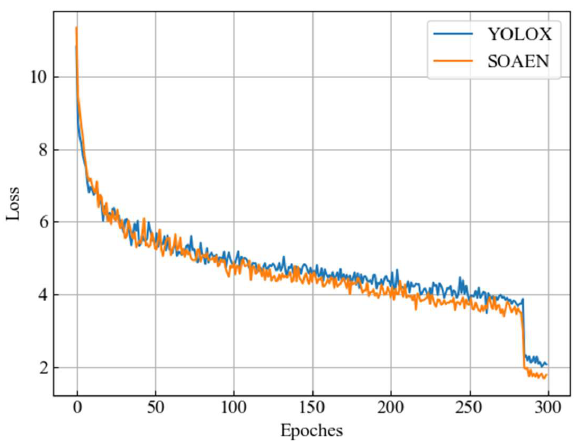
Figure 5. Loss curves of the SOAEN and YOLOX during sample training.